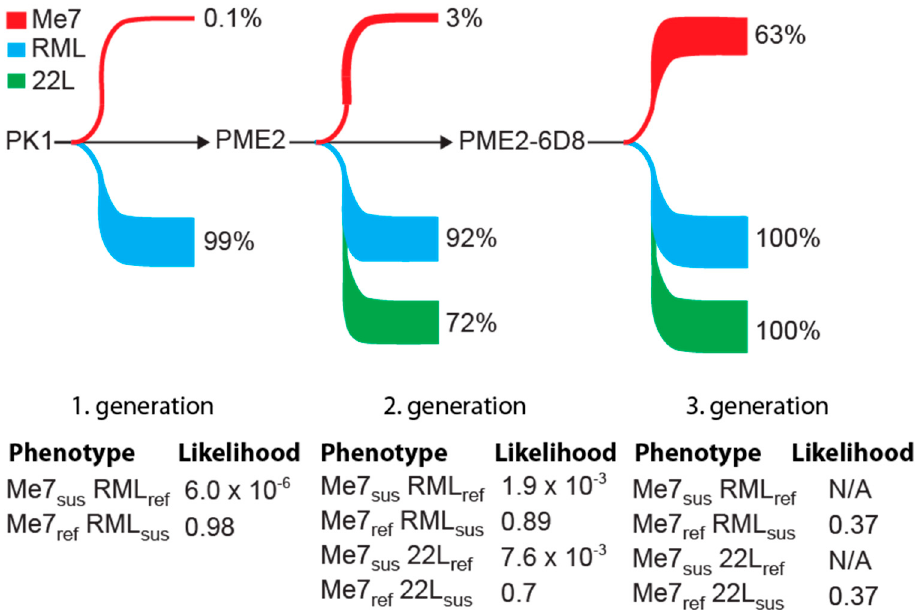
Figure 6. Phenotypic changes in susceptibility to mouse-adapted prion strains during enrichment of Me7-susceptible cells. Schematic representation of changes in susceptibility of PK1-derived clones to the three mouse adapted prion strains Me7, RML, and 22L during enrichment of a Me7-susceptible phenotype. Depicted is the proportion of cells susceptible to the specified prion strains. Likelihoods of isolating distinct phenotypic cells were calculated from data of Supplementary Table S1. N / A: not applicable; briefly, phenotypes RML- and 22L- are not available in third generation cells, since all the clones are permissive to RML and 22L, respectively.